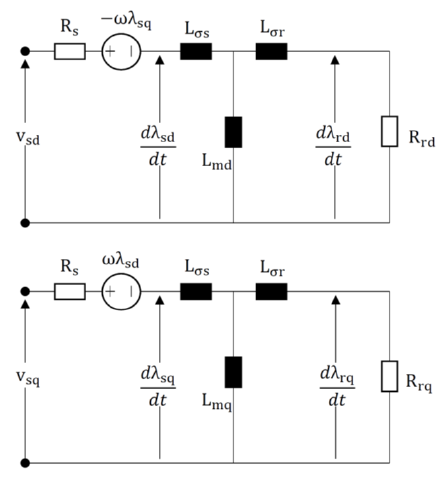
Figure 3. d -, q -axis equivalent circuit of LSSynRM.